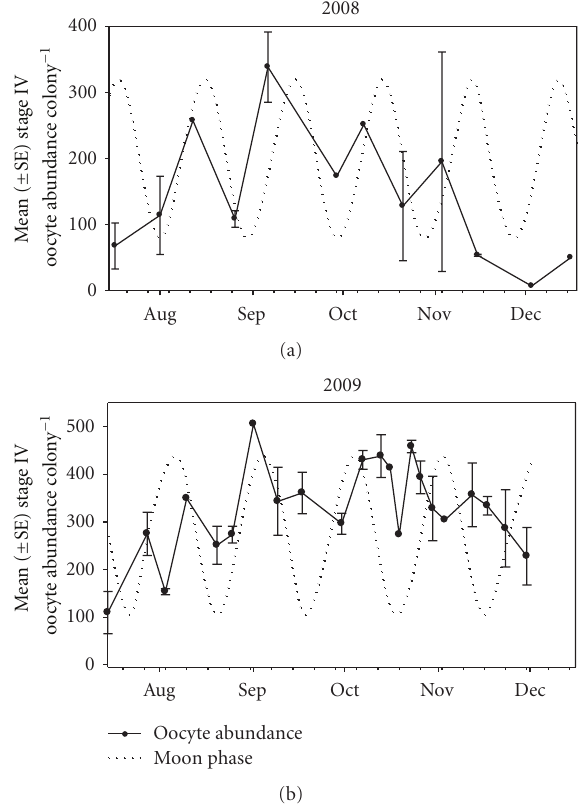
Figure 5: Solenastrea bournoni mean ( ± SE) abundance of stage IV oocytes per colony at each sampling date with moon phases for years 2008 and 2009; full moons represented by peaks in moon phase line.